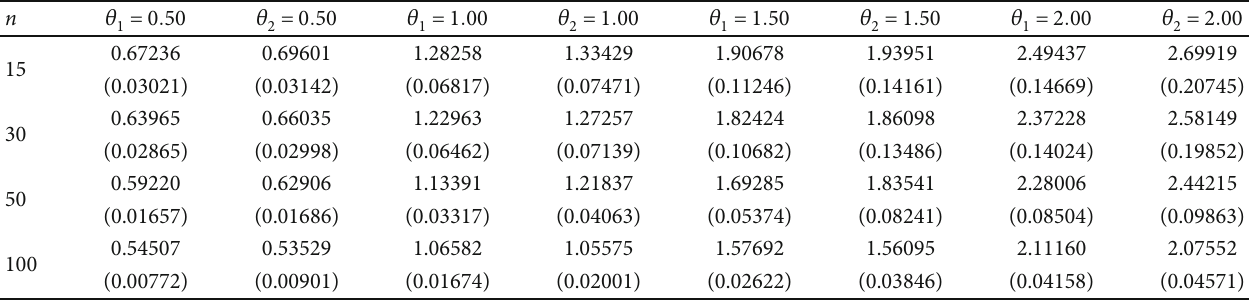
Table 10: ML estimates under di ff erent sample sizes.